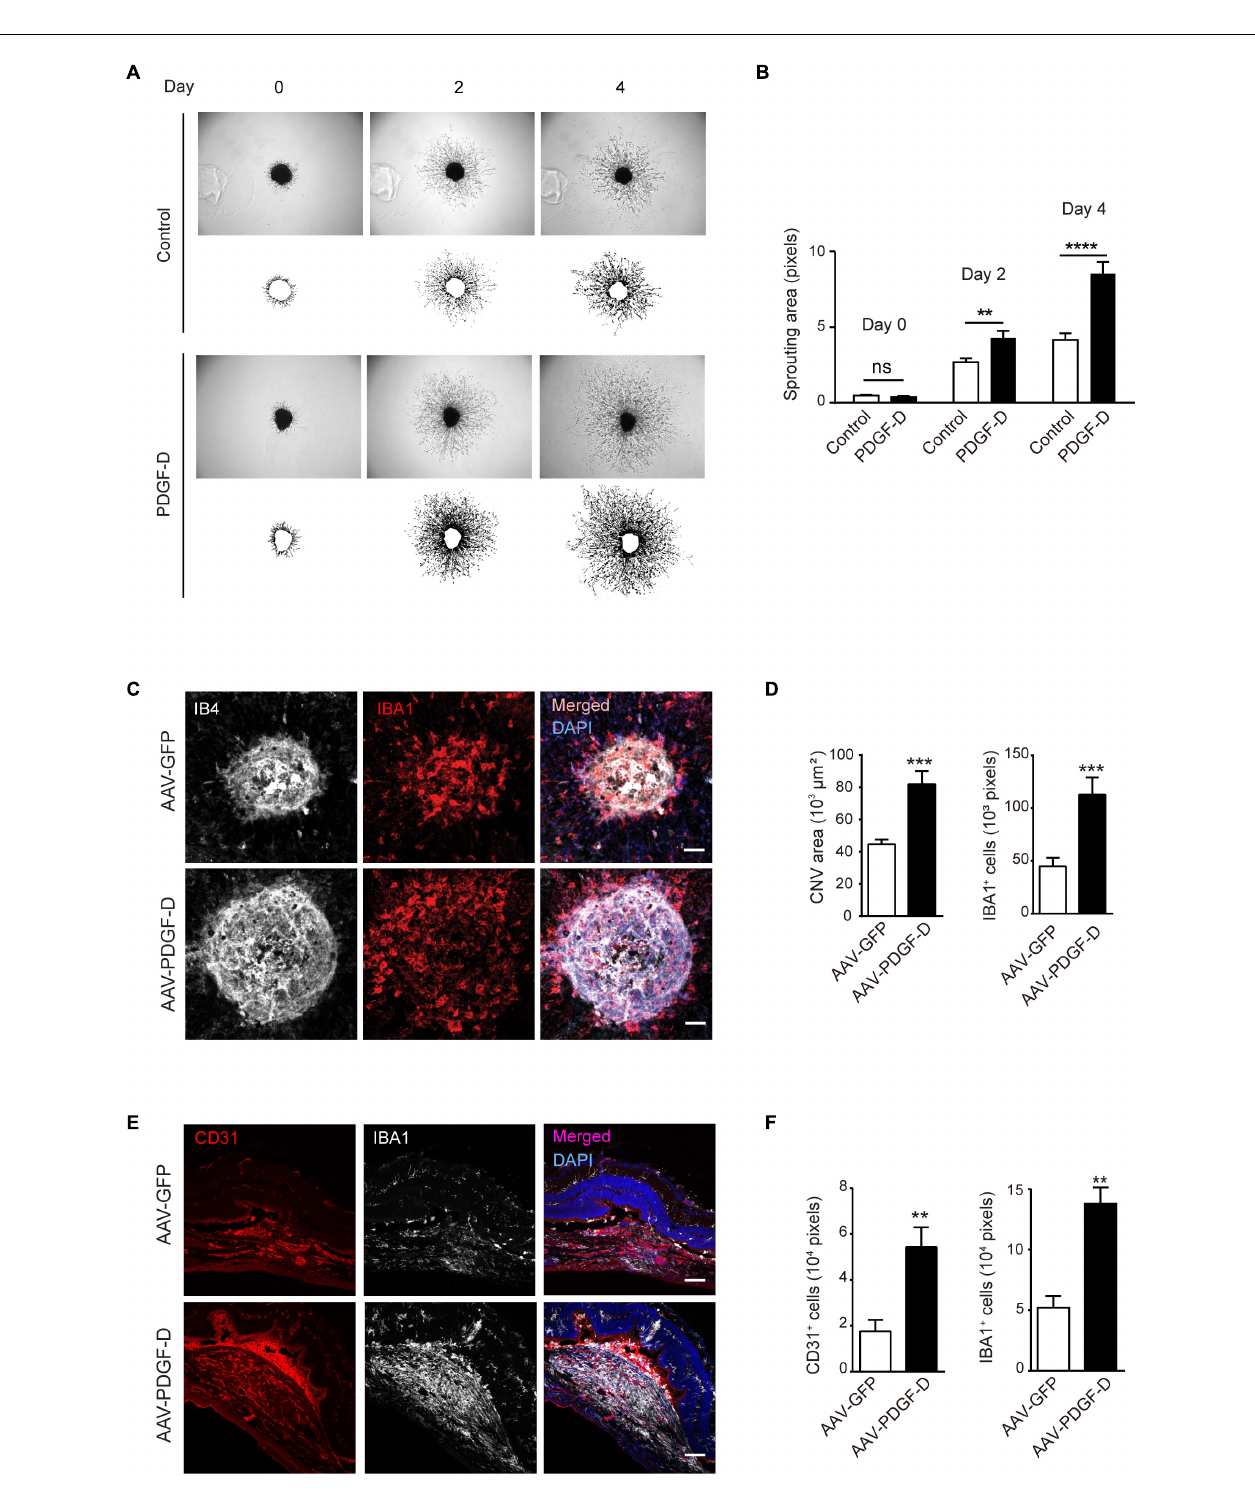
FIGURE 6 | PDGF-D promotes choroid sprouting and pathological choroidal neovascularization (CNV). (A) PDGF-D protein treatment increased mouse choroidal sprouting at different days. (B) Quantifications of choroidal sprouting areas in (A) . (C) RPE-choroid wholemount immunofluorescence staining of IB4 + neovessels and IBA1 + macrophages in laser-induced CNVs with AAV-GFP or AAV-PDGF-D overexpression. (D) Quantifications of neovascular areas and IBA1 + macrophages in (C) . (E) Immunofluorescence staining of CD31 + ECs and IBA1 + macrophages in laser-induced CNVs. (F) Quantifications of the CD31 + ECs and IBA1 + macrophages in e. Scale bar: 50 µ m. n = 5, ** p < 0.01, *** p < 0.001, **** p < 0.0001, ns: not significant.